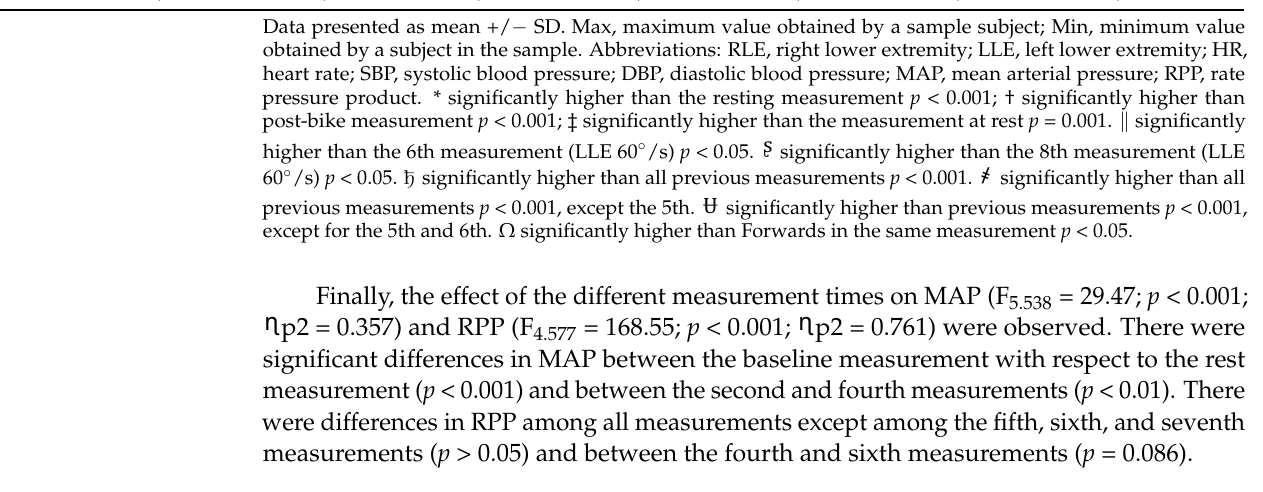
Table 1. Description of the cardiovascular parameters during the isokinetic protocol at different measurements. Means and standard deviations obtained for the global sample (n = 63) and accord- ing to the field position and competition level of the soccer players are shown.